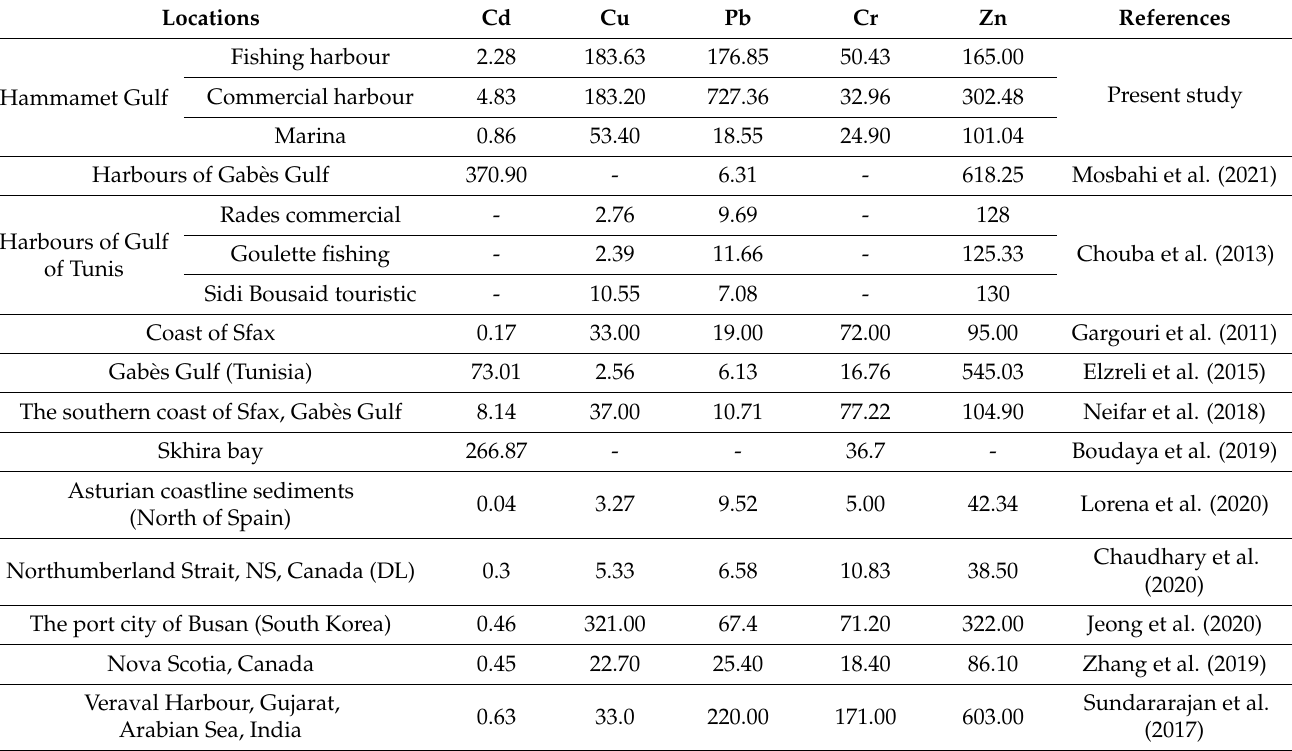
Table 5. Comparison of trace metal concentrations in coastal and harbour environments from different regions (all data collected in previous studies are converted to the same unit ( µ g/g); (-) not assigned).